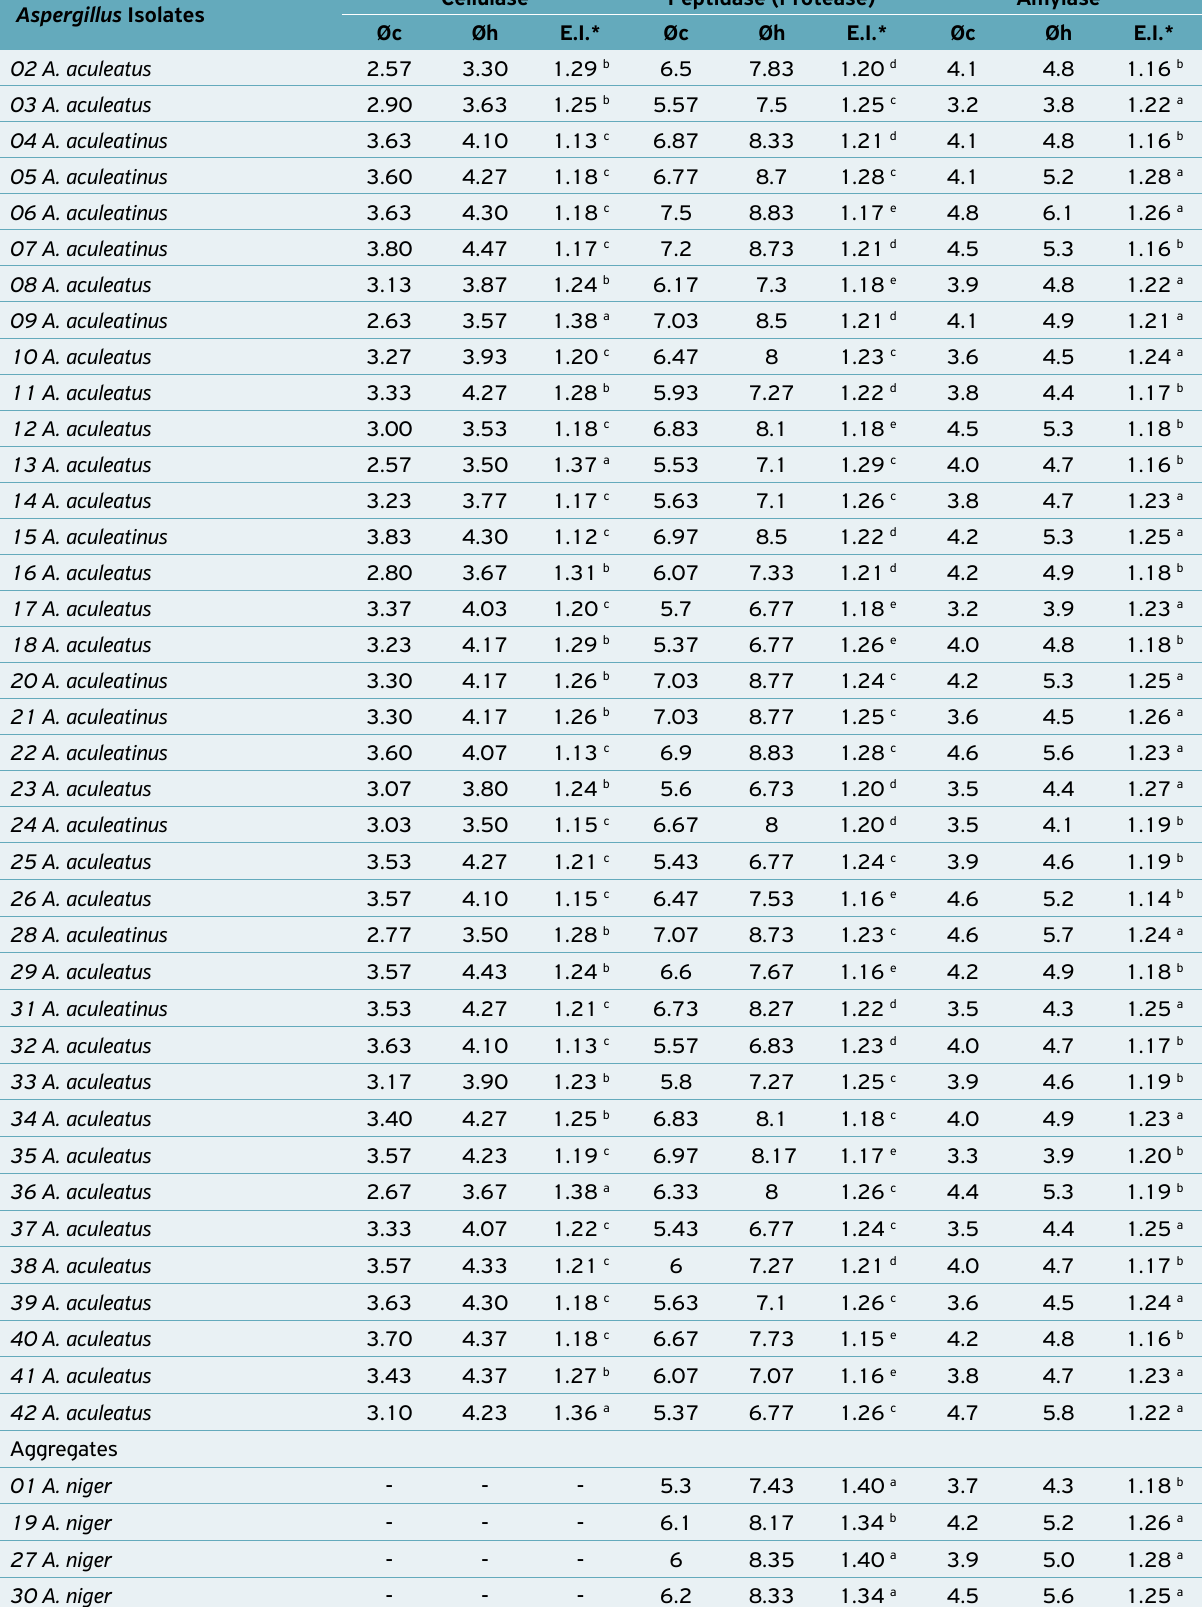
Table 1. Evaluation of the lineages of Aspergillus section Nigri isolated from the plant litter and soil, by their respective Enzymatic